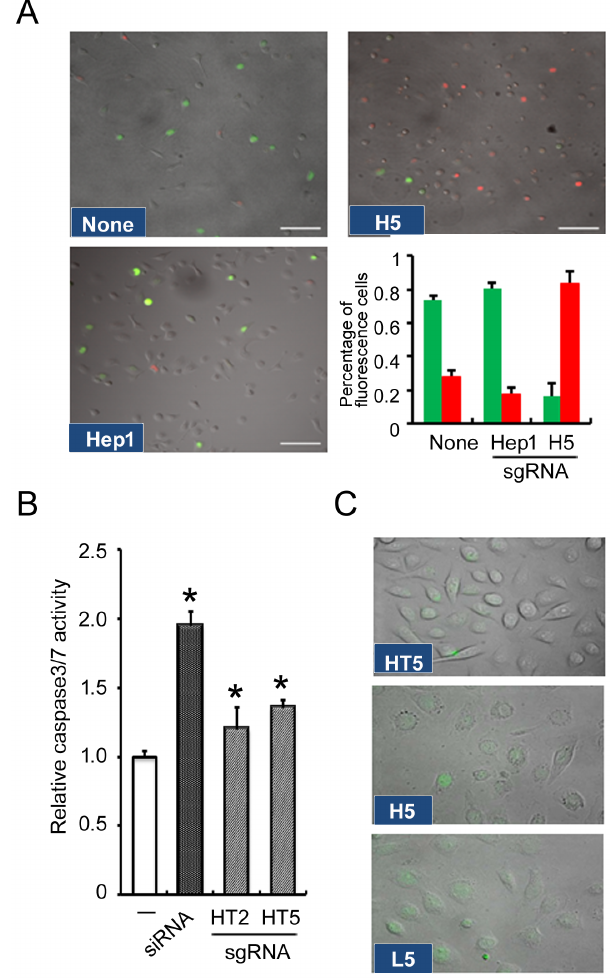
Figure 3. Effects of sgRNA targeting cyclin D1 on cell-cycle and apoptosis. (A) Real-time visualization of cell cycle progression using a fluorescence microscope. HSC-3 cells were plated and cultured for 24 h. In vitro visualization of cell cycle distribution in a fluorescent ubiquitination-based cell cycle indicator (FUCCI) was used. Naked sgH5, sgLucHep1 (unrelated heptamer) or vehicle (None) was added at 200 nM and then cell cycle distribution was monitored using a fluorescence microscope. Scale bars 5 100 m m. (B) Cellular activities of caspases 3/7 were measured 6 h after HSC-3 cells were cultured in the absence (–) or presence of naked sgRNA (200 nM each). siRNA (20 nM) for cyclinD1 with Lipofectamine 2000 was used as positive control. Fold-increase in activity was calculated based on activity measured from control cells. (C) Caspase 3/ 7 activity of cells treated with sgRNA targeting cyclin D1. HSC-3 cells were plated and cultured for 24 h. Naked sgHT5, sgH5 or sgL5 was added at 200 nM and then caspase 3/7 activity was visualized by a caspase 3/7 Green Detection Reagent. Each assay represents a separate experiment performed in triplicate. Data are means ¡ S.D.* P , 0.05.